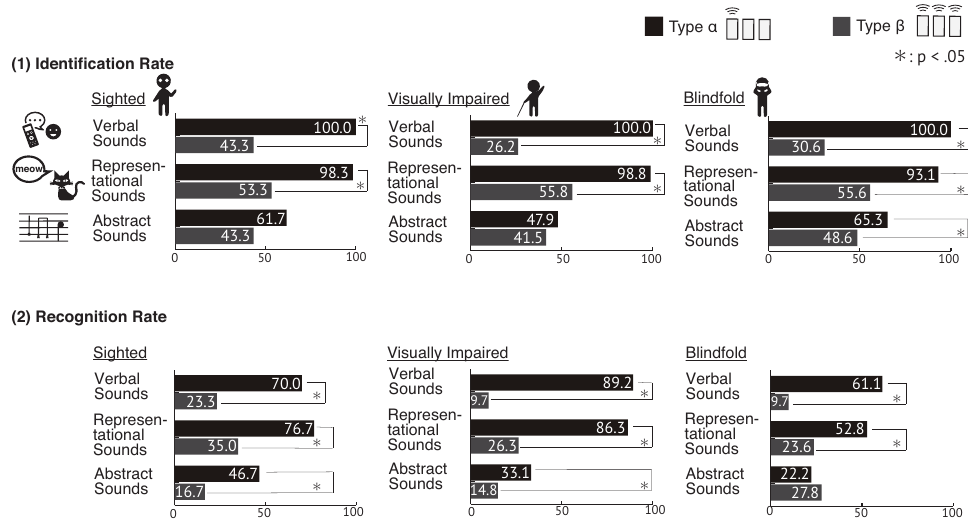
Figure 9. Differences in performance by the style of sound